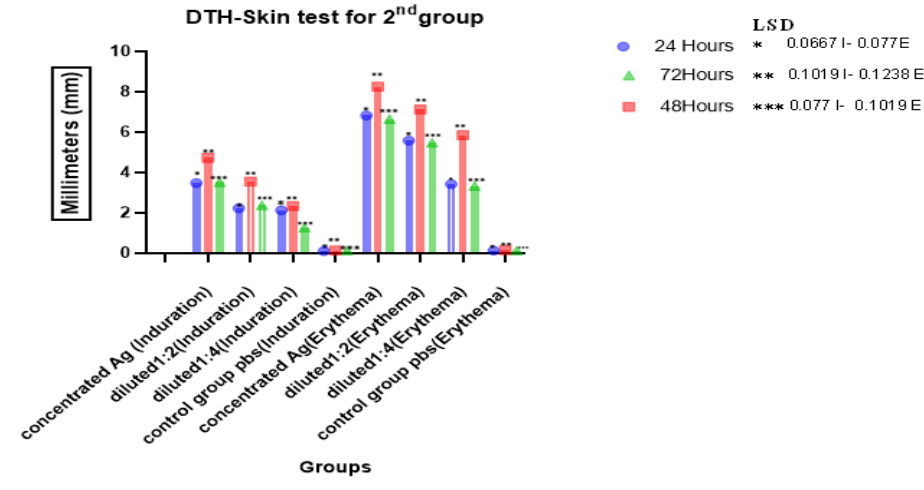
Figure 4. DTH induration and erythema of rabbits immunized by LPS antigen